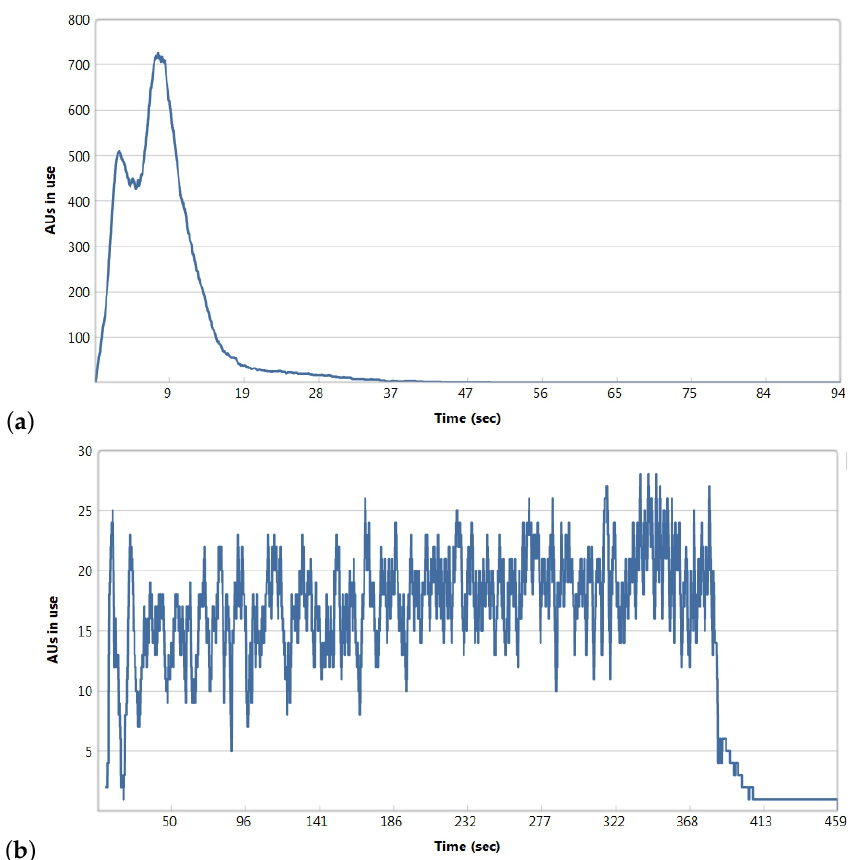
Figure 6. Use of compute resources (AUs) during the whole extraction process on data set DS1 for ( a ) 1024 AUs, and ( b ) 32 AUs assigned to the